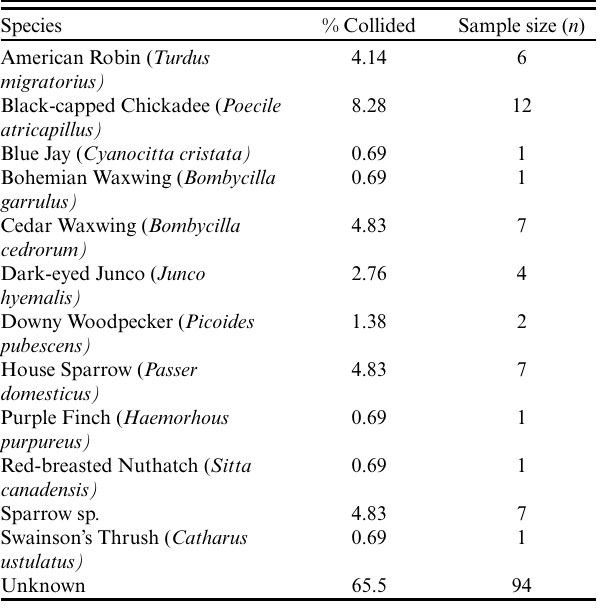
Table 1 . Percentage of reported collisions and the sample size for each species that